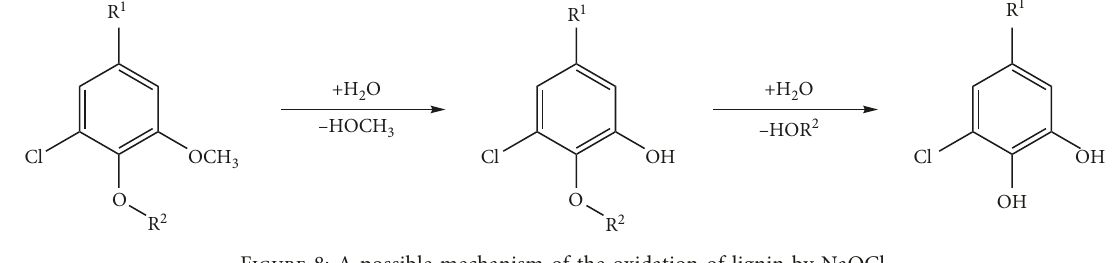
Figure 8: A possible mechanism of the oxidation of lignin by NaOCl.